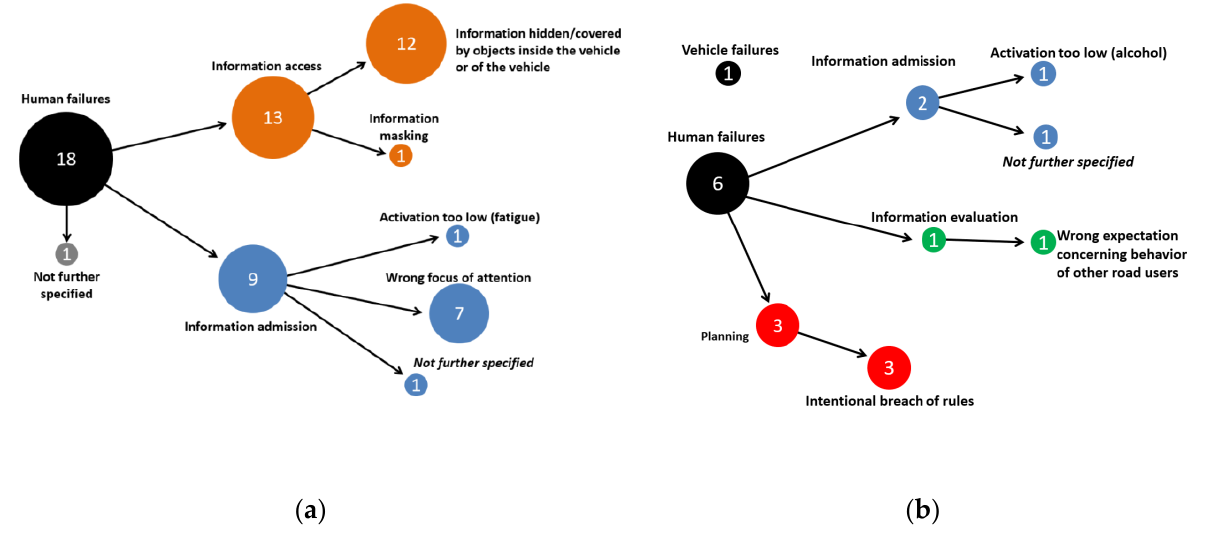
Figure 13. ACAS analysis of truck drivers ( a ) and cyclist ( b ) for Scenario 2 (right-turn crashes).